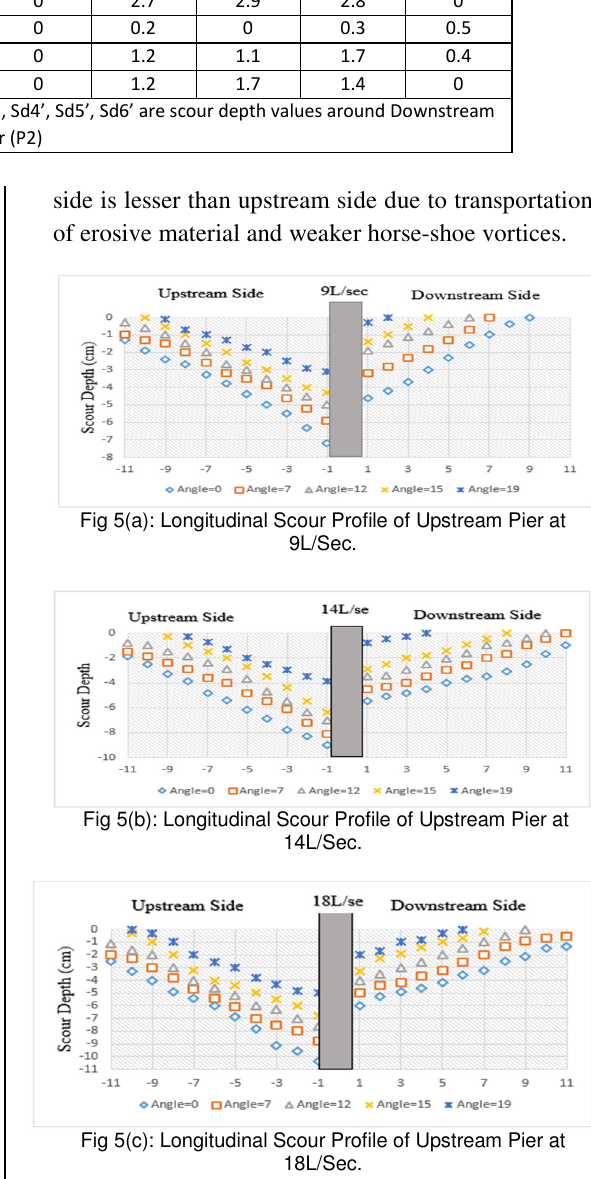
Fig 5(c): Longitudinal Scour Profile of Upstream Pier at